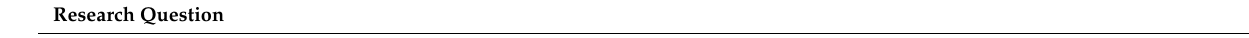
Table A2. Search Strategy and Example Medline Search